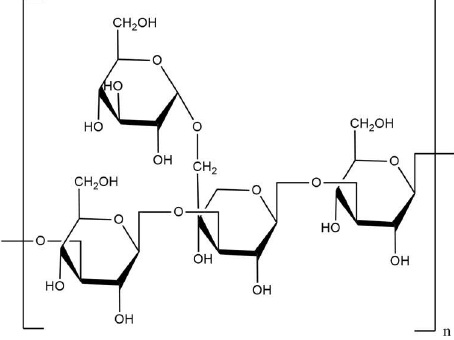
Figure 2. The chemical structure of schizophyllan.